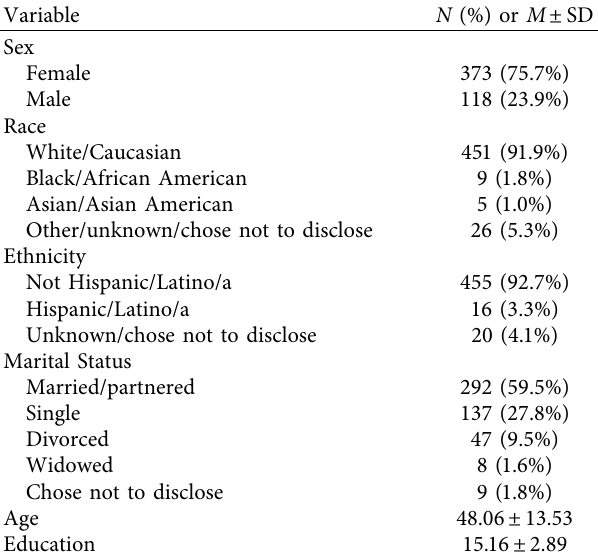
Table 1: Demographic characteristics ( N �